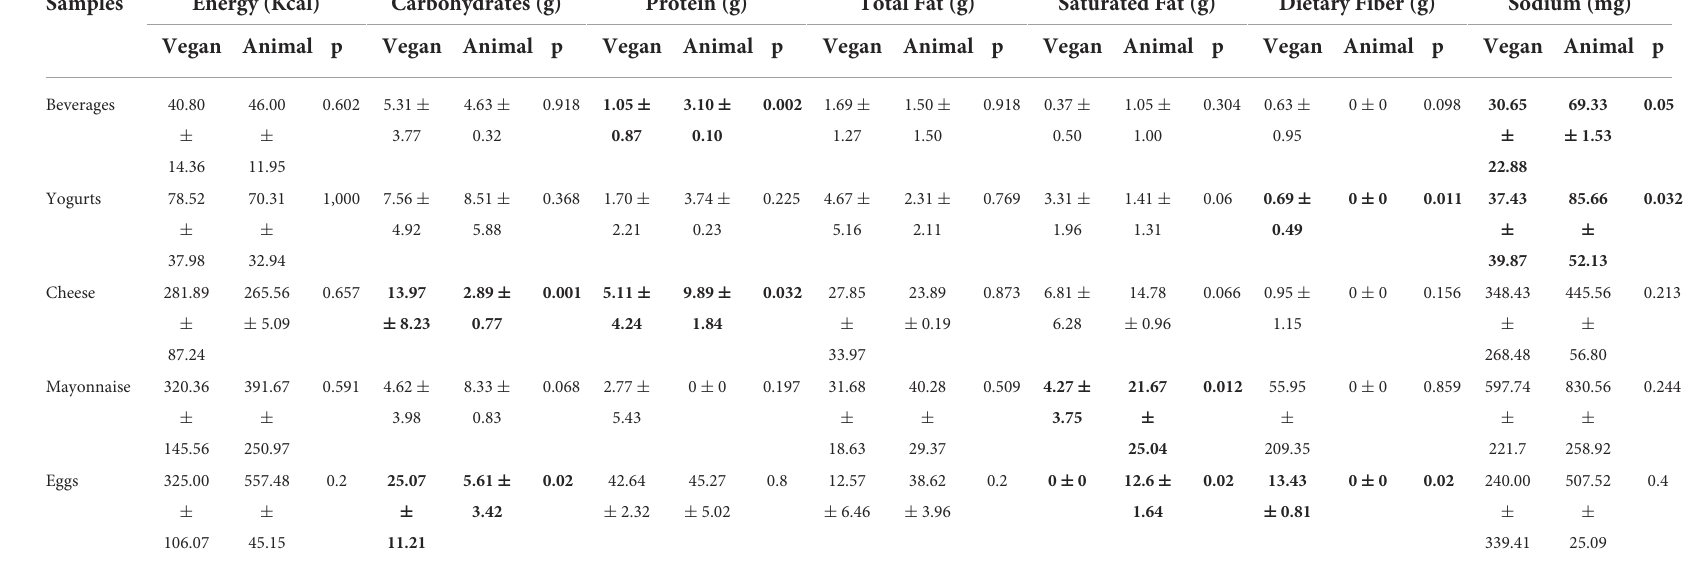
TABLE 1 Means and standard deviations (SD) of the nutritional values per 100g of serving of the included